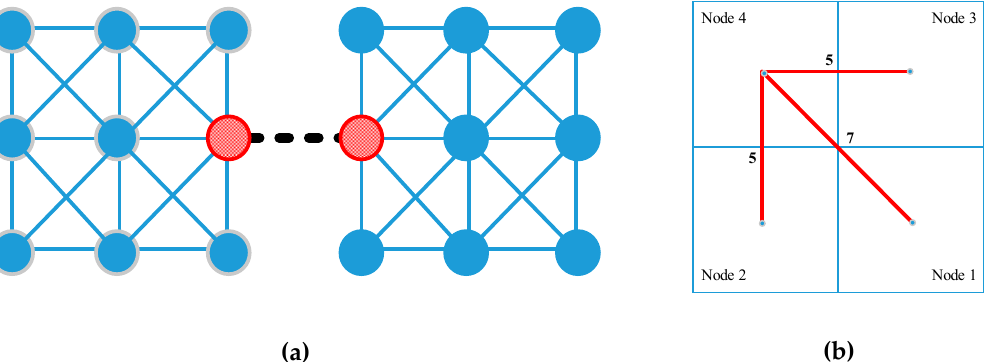
Figure 4. Nodes of gates and weights of edges: ( a ) nodes of a gate (red circles) and entrance edge (dashed line); ( b) weights of edges.